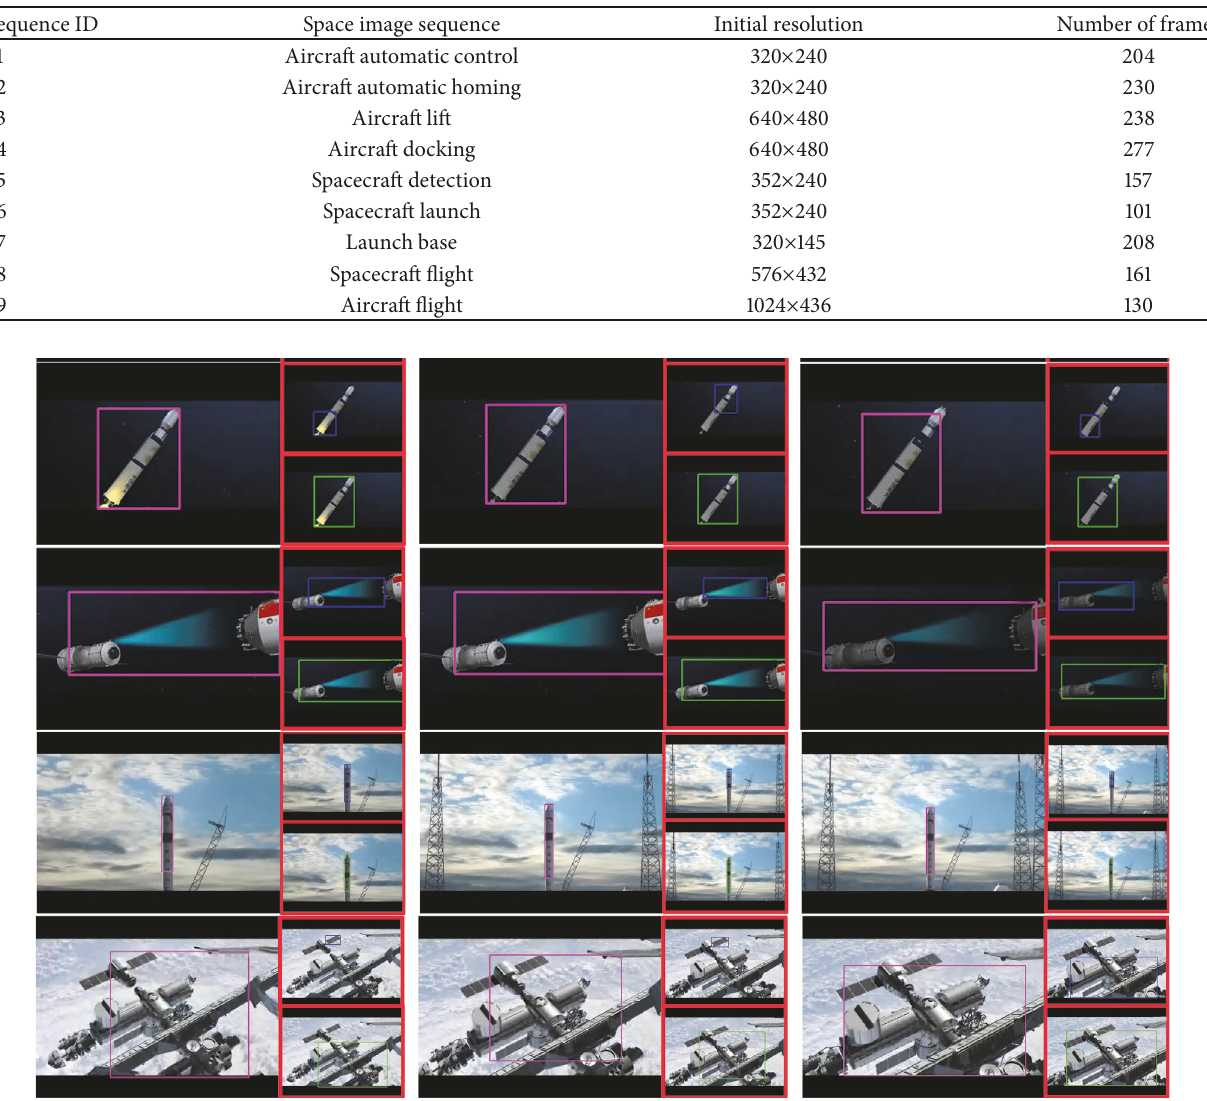
Figure 5: The obtained attention regions using PTDS from sample frames of different image sequences (from top to down, sequences S1, S2, S3, and S4). In each subfigure, the purple-bordered regions mark the attention regions, the blue-bordered regions mark the spatial attention regions, and the green-border regions mark the temporal attention